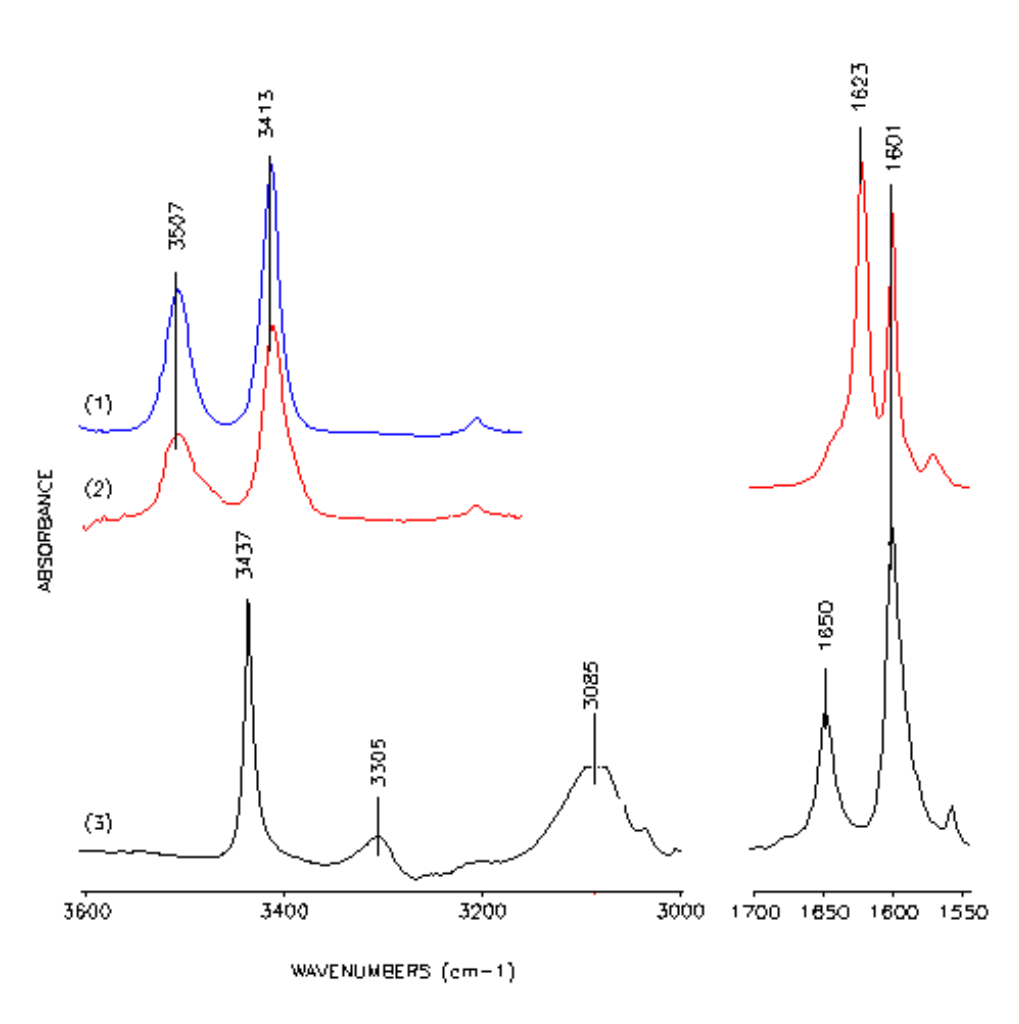
Fig. 1 NH 2 –stretching and scissoring region of 4-AP: diluted solution in carbon tetrachloride (1) and chloroform (2); solid state – KBr disk